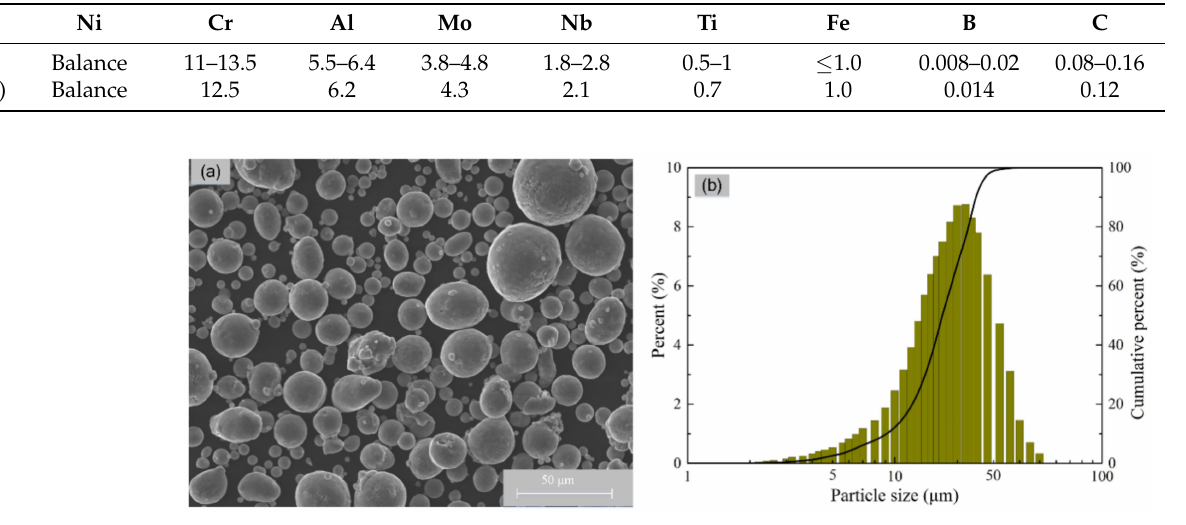
Figure 1. K418 powder: ( a ) SEM micrograph, ( b ) particle size distribution.